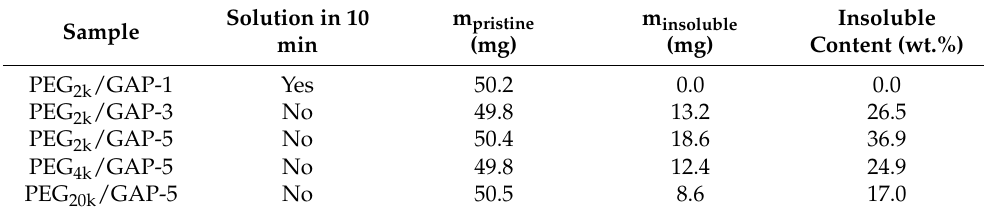
Table 1. Results of solubility tests of PEG/GAP samples after UV